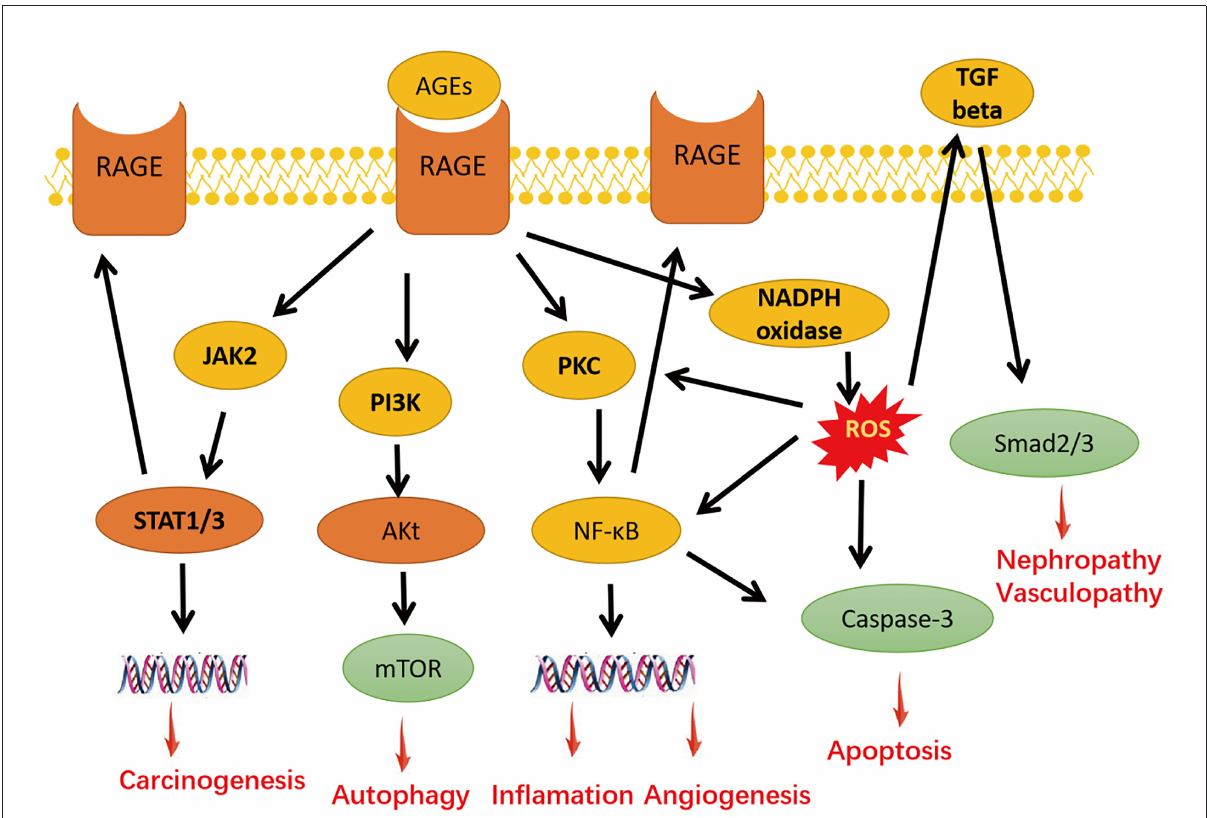
FIGURE2 The AGE and RAGE axis and its downstream signaling pathways. The interaction of AGE–RAGE activates downstream signaling, including nuclear factor- κ B (NF- κ B) signaling pathway, transforming growth factor- β (TGF- β ) pathway, Jak-STAT pathway, PI3K-Akt pathway, to promote inflammation, apoptosis, autophagy, angiogenesis, and nephropathy and vasculopathy, and induces the generation of reactive oxygen species (ROS) through nicotinamide adenine dinucleotide phosphate (NADPH)